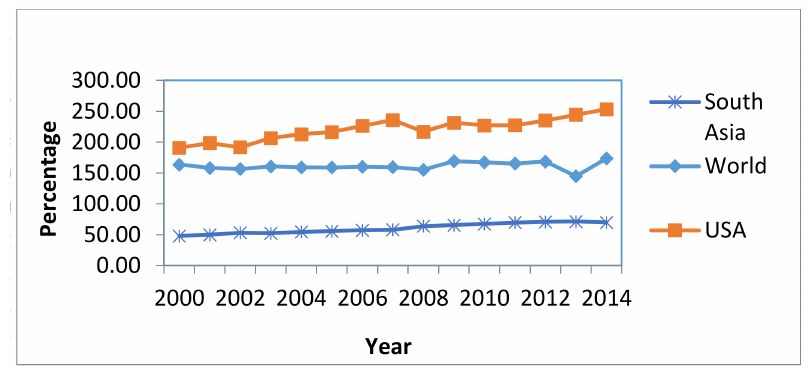
Figure 3. Domestic credit as a percentage of GDP (Source: World Development Indicators-World Bank).